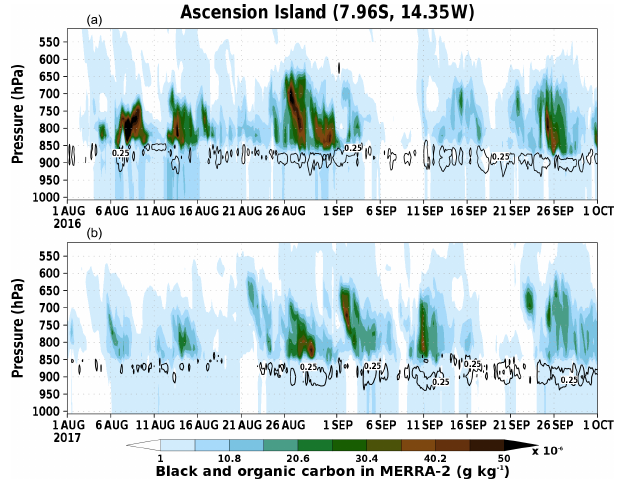
Figure 2. Vertical profile of the mixing ratio of black and organic carbon for the (a) 2016 and (b) 2017 biomass burning seasons from MERRA-2. Black contours indicate a cloud fraction of 0.25.